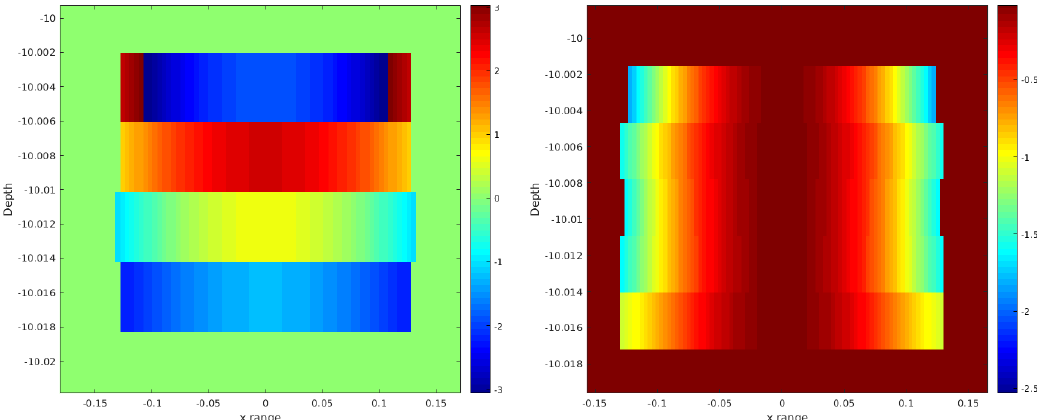
Figure 2. Phase Comparison of different reconstruction step-widths and its effects on the phase-structure of the imaging reconstruction. The parameters are f s = 200 kHz, f 0 = 400 kHz and pulse length T p = 1